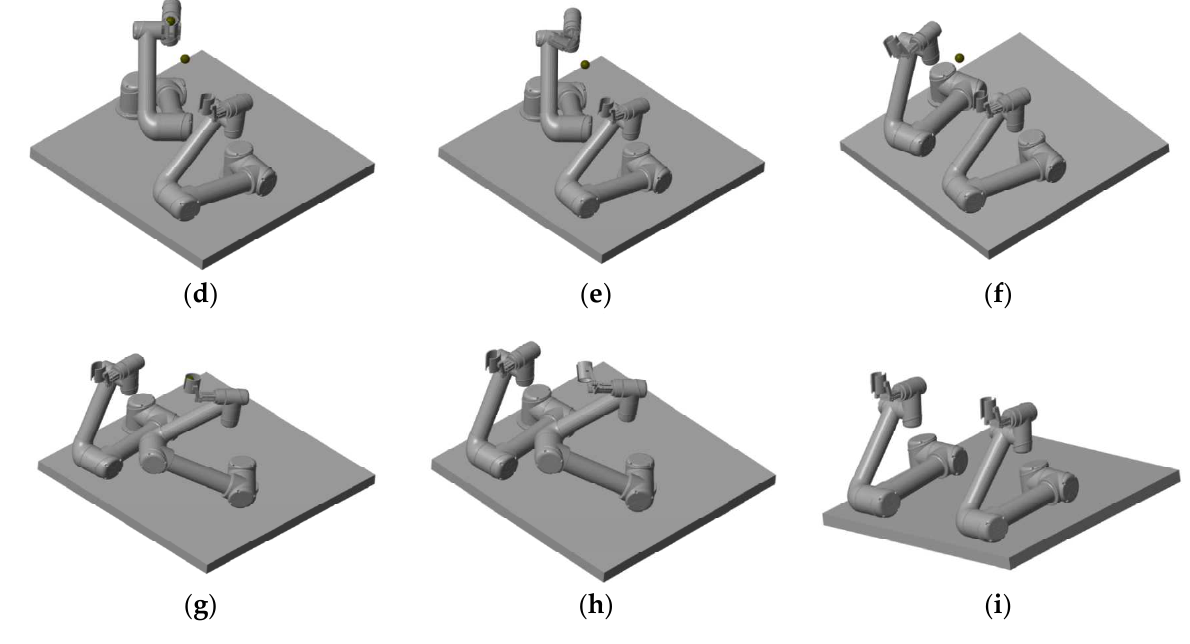
Figure 18. Simulation process of two-arm movement in the collision area. ( a ) Initial position. ( b ) Collision detection. ( c ) Left robot arm positioning fruit. ( d ) The left robot arm grasps the fruit. ( e ) The left robot arm separates the fruit. ( f ) The left robot arm reaches the initial position. ( g ) The right robot arm grasps the fruit. ( h ) The right robot arm separates the fruit. ( i ) The right robot arm reaches the initial position.